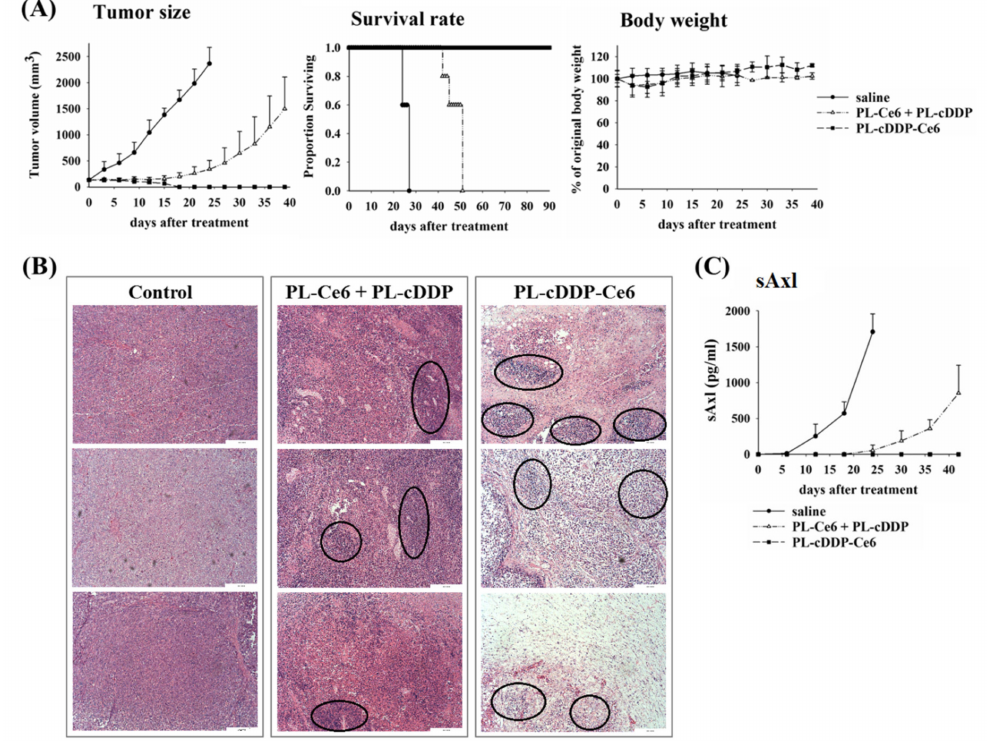
Figure 4. Therapeutic outcome and histological analysis of mice under the impact of PL-cDDP-Ce6 or PL-Ce6 and PL-cDDP in combination. Liposomal drugs (3.5 mg / kg of cDDP and 1. 5 mg / kg of Ce6) were intravenous injected into tumor-bearing mice. Then, light irradiation (100 J / cm 2 ) was applied onto the S462-TY xenograft tumor at 2 and 12 h, respectively, post-drug administration. ( A ) After treatment, tumor size (left panel), survival curve (middle panel) and body weight (right panel) were recorded and analyzed. The data are expressed as mean ± S.D. for each group (N = 5). ( B ) S462-TY tumor-bearing mice were treated with saline (left panel), PL-Ce6 and PL-cDDP in combination (middle panel) and PL-cDDP-Ce6 (right panel). Tumor was harvested three days after treatment, then the tissue sections were stained with hematoxylin-eosin. The circles show the inflammatory necrotic tissues. ( C ) The levels of sAxl corresponding to the tumor size were analyzed against the days after